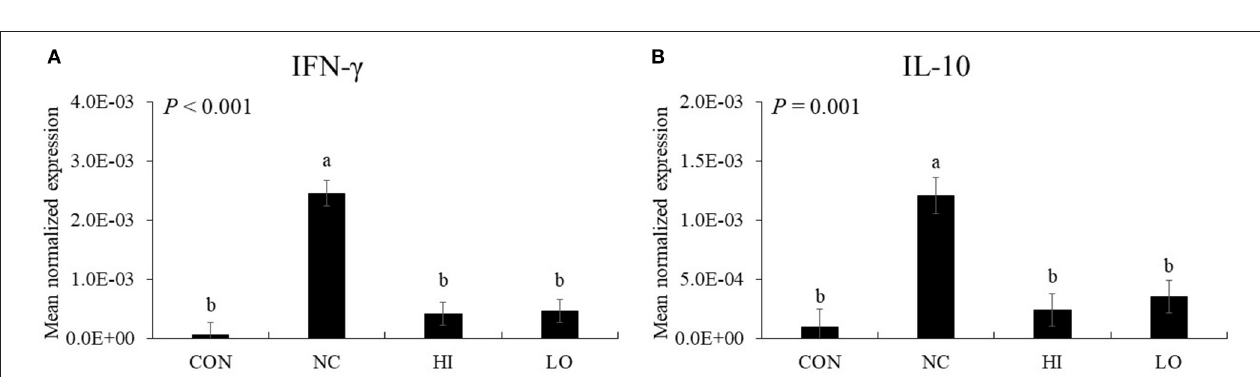
FIGURE 8 | Transcripts of proinflammatory cytokines in jejunum of chickens fed diet supplemented with maltol during infection with E. maxima in experiment 2. CON, basal diet; NC, basal diet for infected chickens; HI, maltol at 10.0 mg/kg feed; LO, maltol at 1.0 mg/kg feed; all chickens except CON were infected by oral gavage at day 14 with 1.0 × 10 4 oocysts/chicken of E. maxima. a,b Bars with no common letter differ significantly ( P < 0.05). Each bar represents the mean ± SEM ( n = 4). The data were collected at day 20 (6 days post-infection). Transcript levels of the cytokines were measured using quantitative RT-PCR and normalized to GAPDH transcript levels.